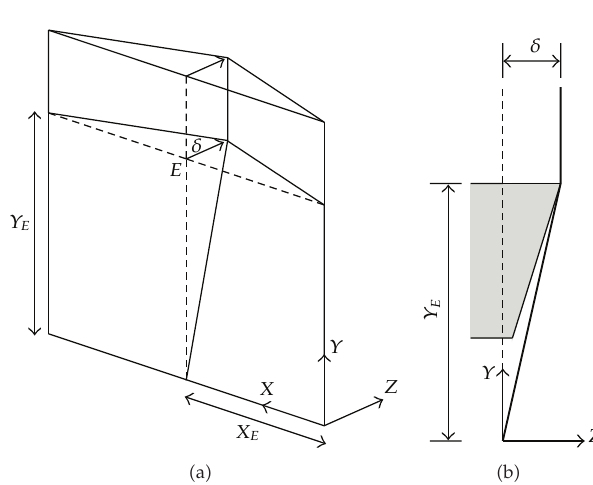
Figure 17: (cid:6) a (cid:7) Assumed displacements field. (cid:6) b (cid:7) Displacement profile in the plan X (cid:9) X E